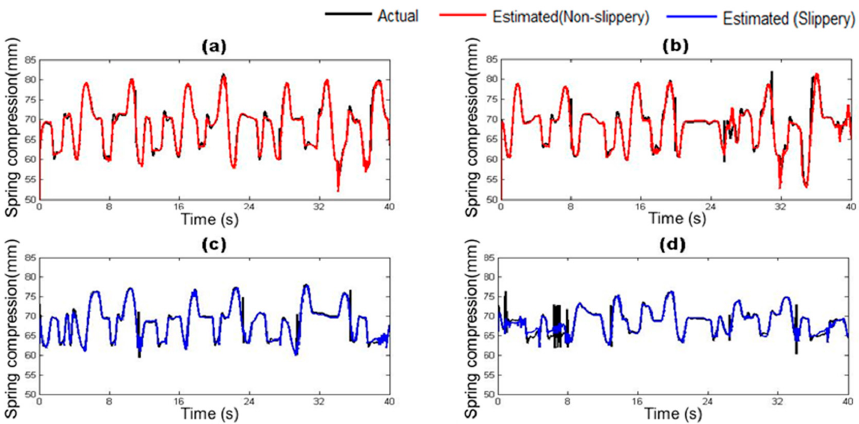
Figure 13. Estimated Roll rate depending on road surface condition: ( a ) Dry asphalt; ( b ) Gravel; ( c ) Wet; and ( d ) Snowy.